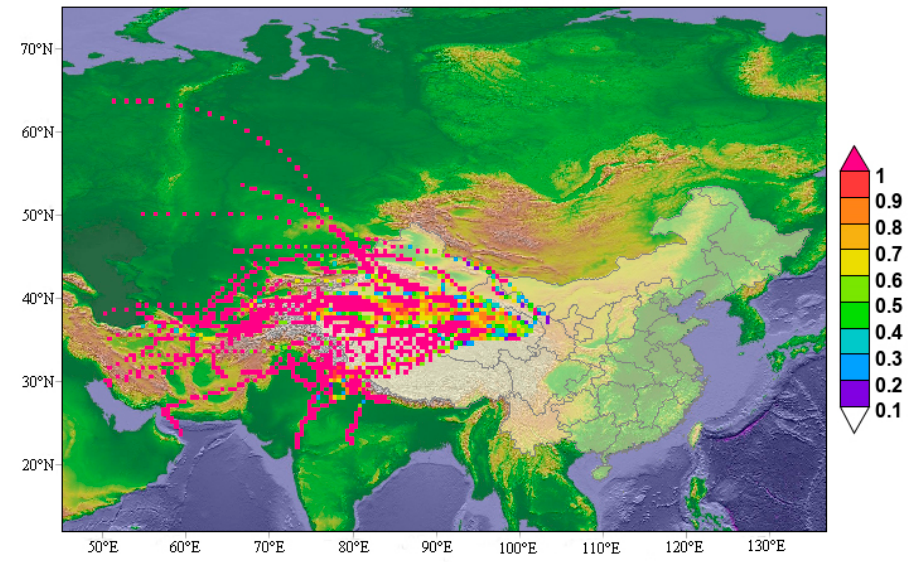
Figure 6. Spatial contribution of PM 2.5 simulated by potential source contribution function (PSCF) model.